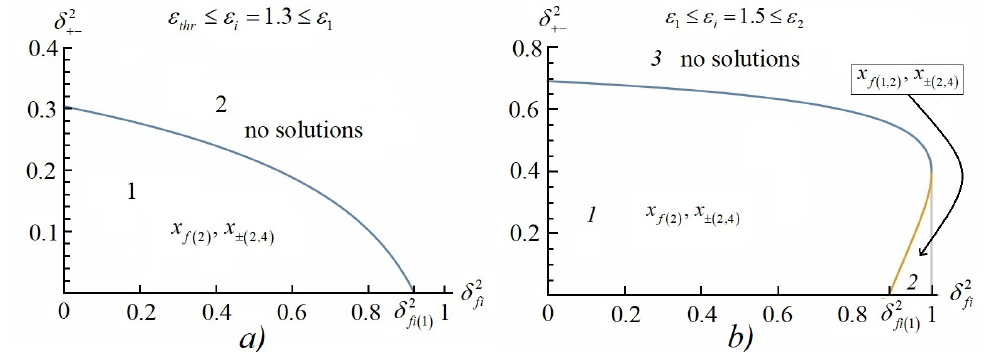
Figure 6. ( a ) Regions in ( δ 2 , δ 2 + − ) –space with different possible values of particle energies. The en- fi ergy of the initial electron is ε thr ≤ ε i = 1.3 ≤ ε 1 (see Condition (38)). The blue line shows the (cid:16) (cid:17) δ 2 dependence of the first characteristic opening angle of the pair δ 2 , ε i = 1.3 on the out- + − ( 1 ) fi going angle of the scattered electron at the energy of the initial electron ε i = 1.3. ( b ) Regions in ( δ 2 , δ 2 + − ) -space with different possible values of particle energies. The energy of the initial electron fi is ε 1 ≤ ε i = 1.5 ≤ ε 2 (see Conditions (39) and (42)). The blue line shows the dependence of the first (cid:16) (cid:17) δ 2 characteristic opening angle of the pair δ 2 , ε i = 1.5 on the outgoing angle of the scattered + − ( 1 ) fi electron at the energy of the initial electron ε i = 1.5. The orange line shows the dependence of the (cid:16) (cid:17) δ 2 second characteristic opening angle of the pair δ 2 , ε i = 1.5 on the outgoing angle of the + − ( 2 ) fi scattered electron at the energy of the initial electron ε i = 1.5.